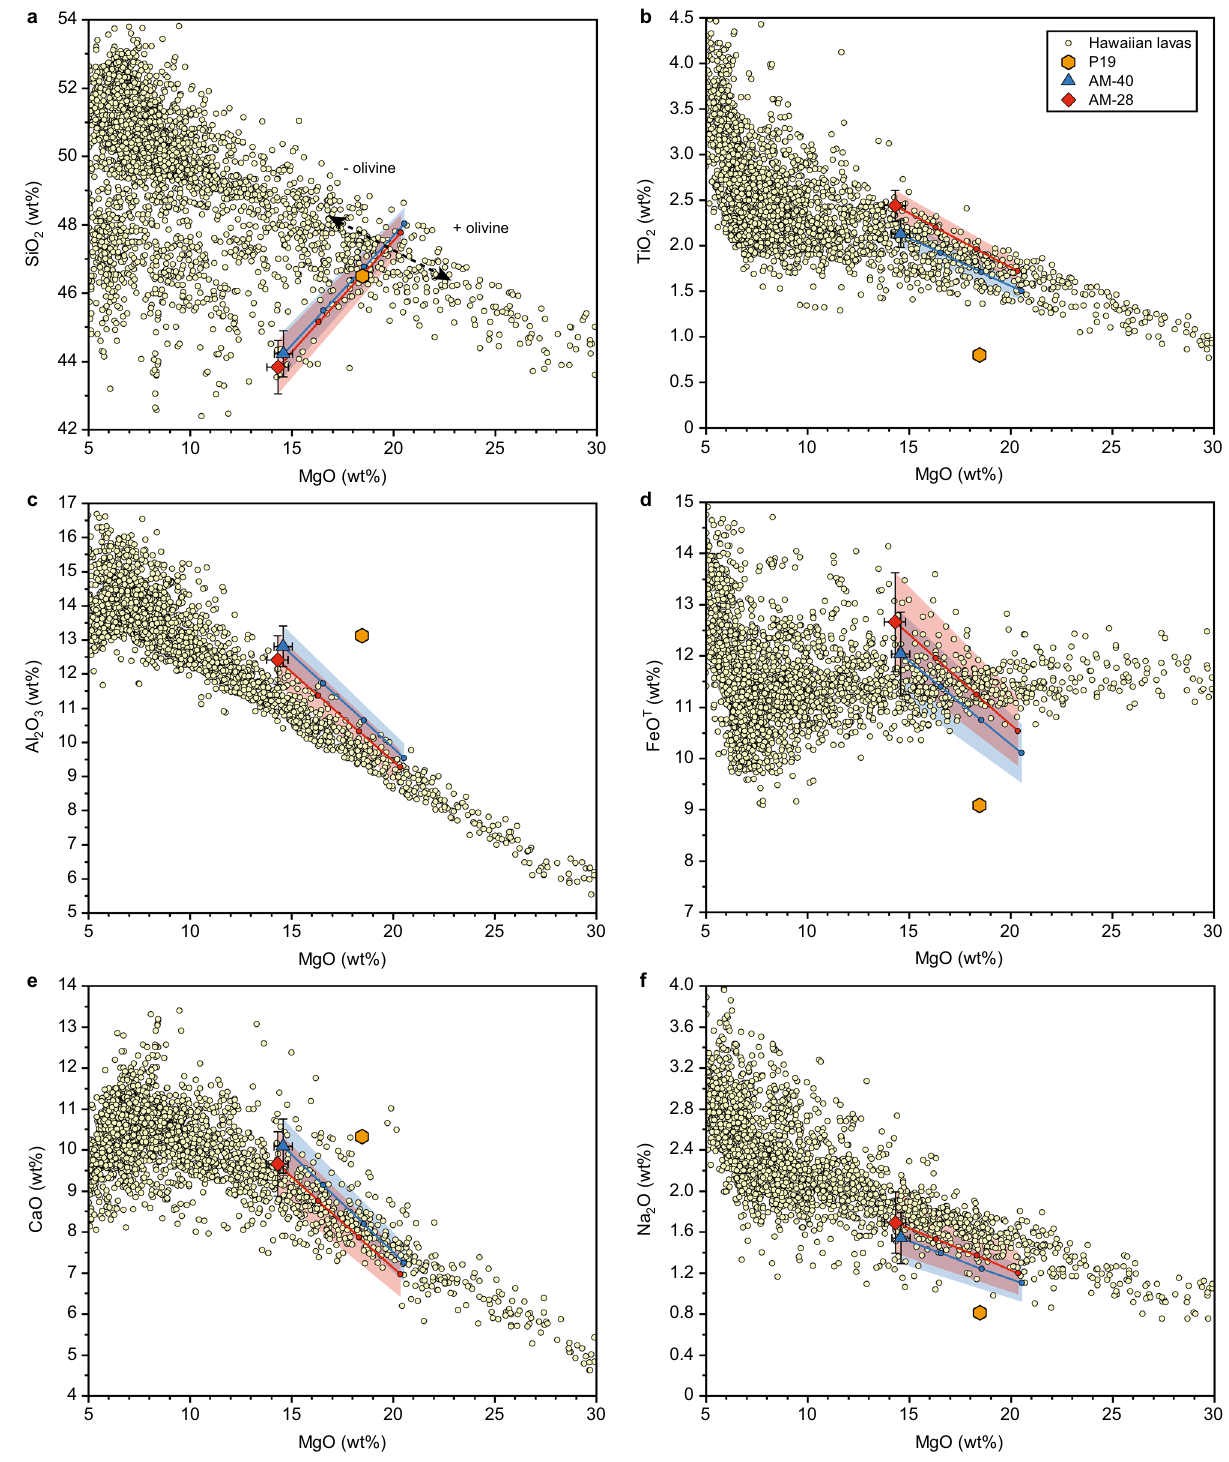
Fig. 1 | The composition evolution of Hawaiin magma during its ascent towards the surface. Compositions of peridotite-derived primary melt (P19) and melts derived from it through clinopyroxene and garnet precipitation (AM-40 and AM-28) in the deep magma chamber and subsequent orthopyroxene assimilation (AM- 40+Opx and AM-28+Opx) compared to the compositions of Hawaiian lavas in terms of ( a ) SiO 2 -MgO, ( b ) TiO 2 -MgO, ( c ) Al 2 O 3 -MgO, ( d ) FeO T -MgO, ( e ) CaO-MgO and ( f ) Na 2 O-MgO. P19, the starting material used in this study, representstheprimarymeltformedbythepartialmeltingofperidotitewithamelt